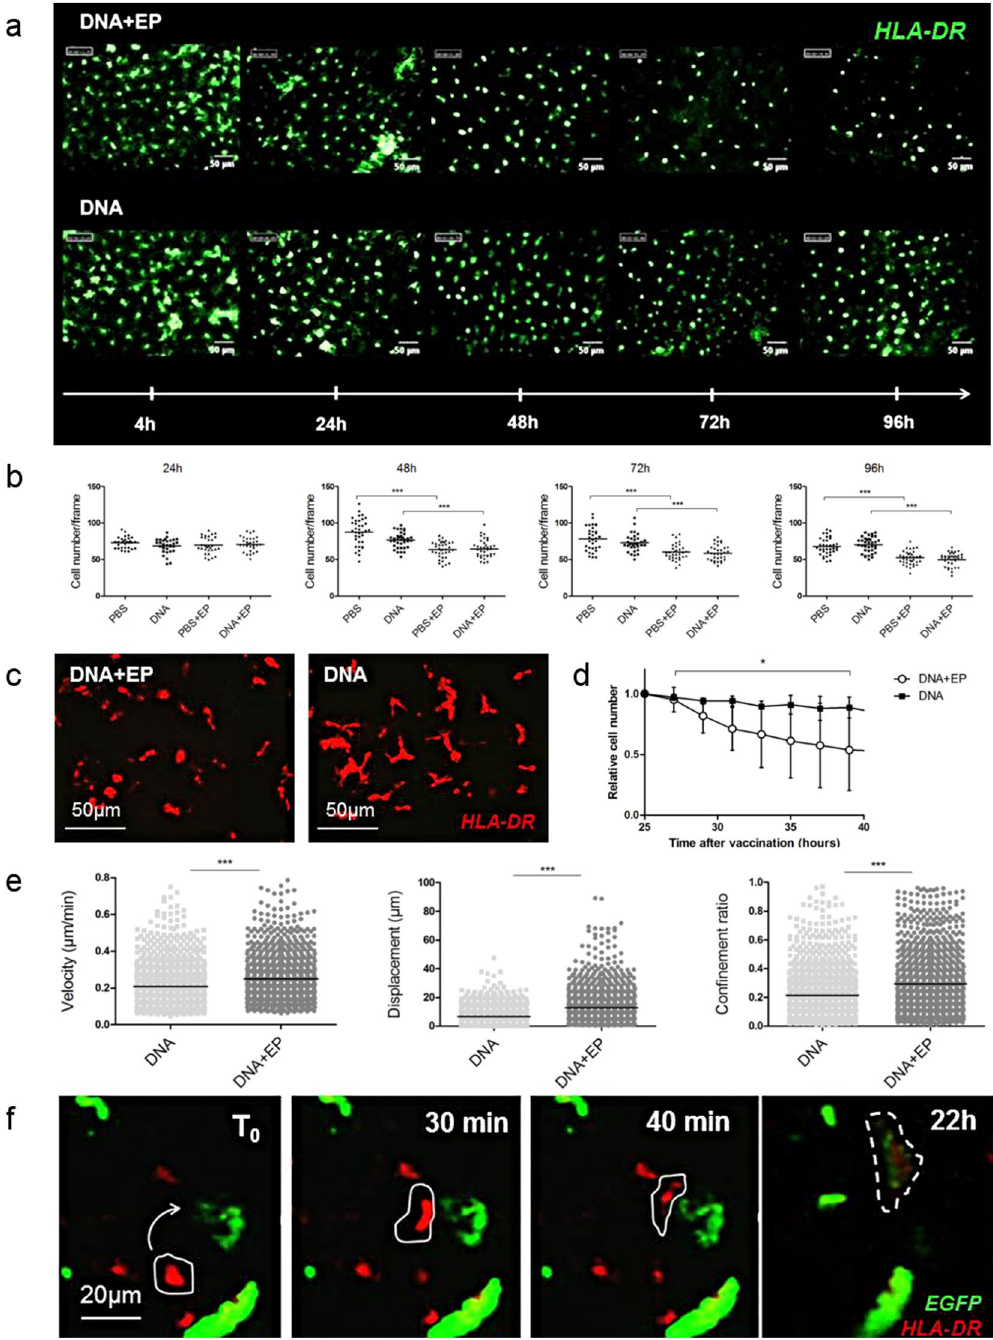
Figure 2. Behavior of LCs at the site of vaccination. ( a ) HLA-DR labeled LC network was visualized by in vivo fibered confocal microscopy and ( b ) quantified at the site of injection. Kruskal-Wallis test. Ex vivo confocal videomicroscopy of HLA-DR-labeled LC, showing ( c ) LC morphology and ( d ) the variation of the LC number normalized to the cell number at the first time point (n = 3). Friedman test. ( e ) LC motility parameters were measured from three independent experiments. Each point represents one cell. Mann–Whitney test. ( f ) Ex vivo confocal videomicroscopy of the epidermis 24 h after vaccination with the auxoGTU ® -Luc-EGFP vector with EP. Arrow indicates APC displacement toward an antigen expressing cell. Dotted line shows a HLA-DR and EGFP co-stained LC. Data are presented as mean ± SD; * p < 0.05; *** p < 0.001; EP,